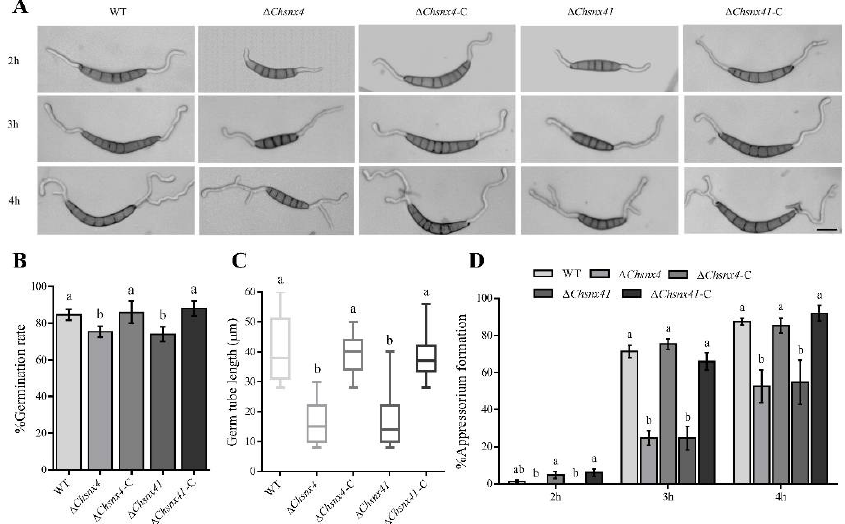
Figure 4. Snx4 and Snx41 are required for conidia germination and germ tube and appressoria for- mation in C. heterostrophus . ( A ) Germ tube and appressoria morphology of WT, mutants, and com- plemented strains at 2 h, 3 h, and 4 h. ( B ) Conidial germination rate of indicated strains. ( C ) Average germ tube length of indicated strains. ( D ) Appressorium formation rate of the indicated strains at 2 h, 3 h and 4 h. Each experiment had three replicates and was repeated three times. (Scale bar 10 μm).